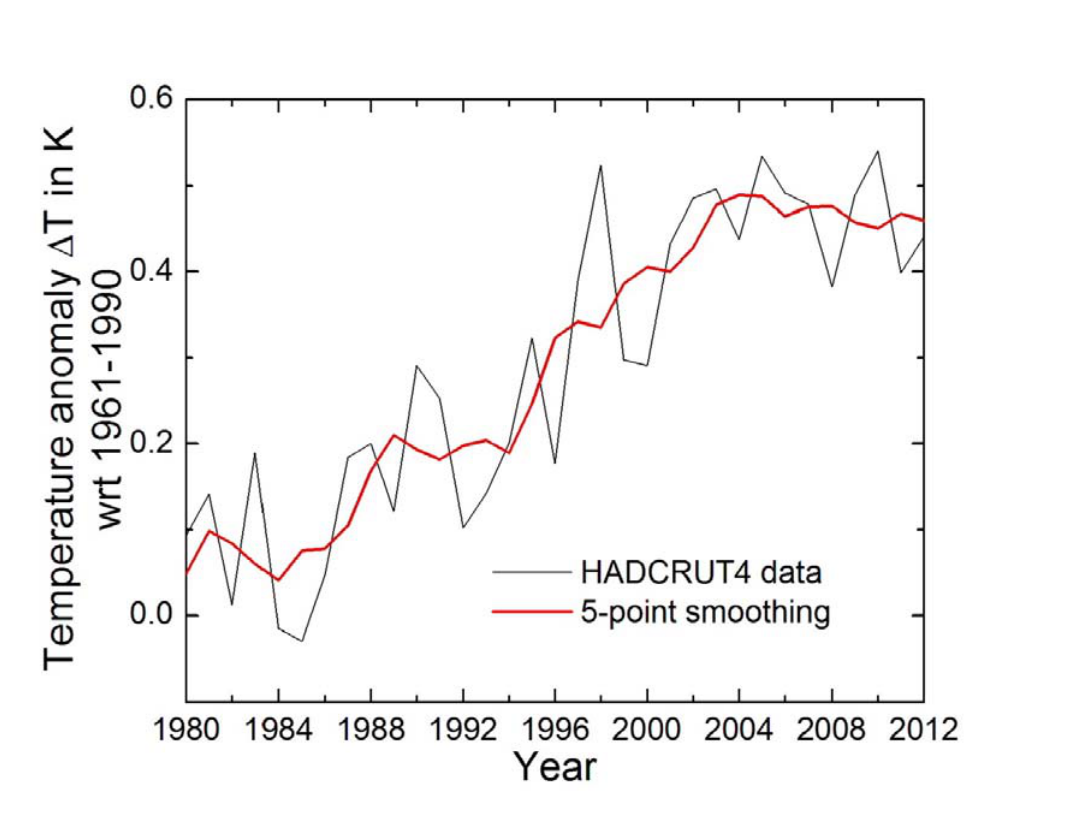
Figure 6. The HADCRUT4 data as illustrated in Figure 5, together with the five-point smoothing, but shown for the interval 1980–2012